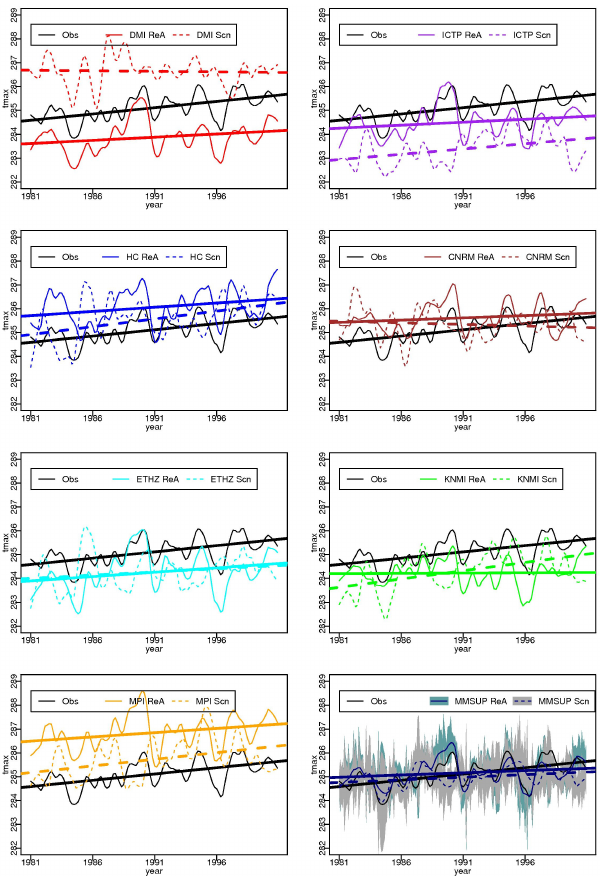
Fig. 5. Comparison between trends from observations obtained with optimal interpolation of Piemonte data (black lines), reanalysis runs (solid lines) and scenario runs (dashed lines) for different models (acronyms in Table 1) and multimodel superensemble (MMSUP) in the period 1981–2000. Multimodel training period: 1961–1980. Multimodel uncertainty (square root of the total multi-normal variance) is represented as confidence bands.